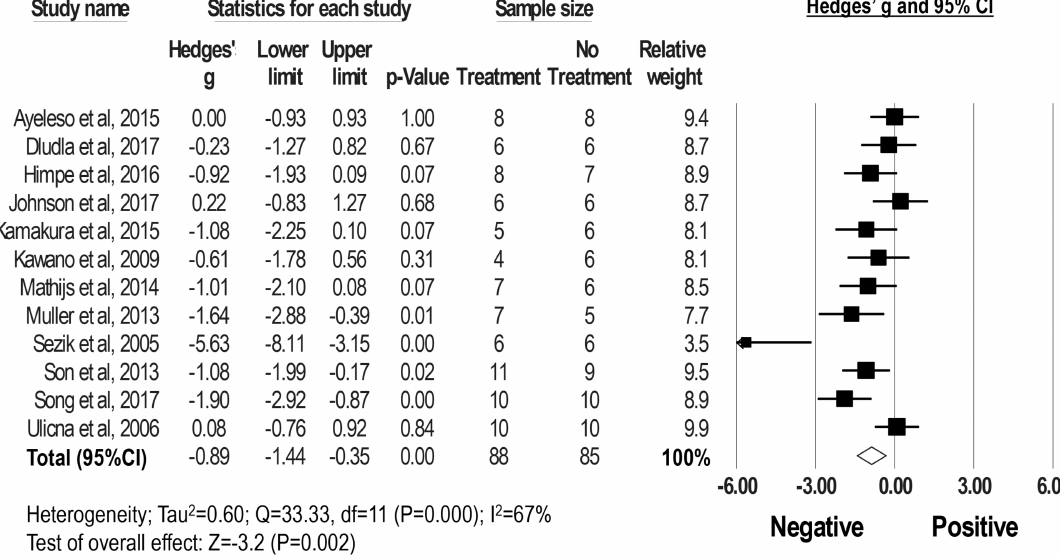
Figure 2. Flow diagram of literature search and selection process. Meta-analysis of Hedges’ g of blood glucose levels in DM rodents with and without treatment of rooibos extracts or associated major phenolic compounds. Summary estimates were analyzed using a random-effects model. CI, confidence interval.